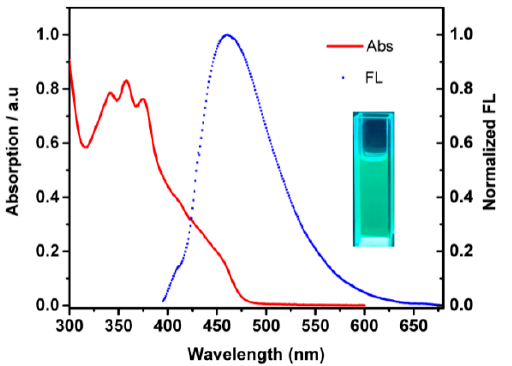
Figure 2. UV-vis absorption (red line) and emission (blue dots) spectra of PyDN in toluene. Insets is photograph achieved under black back light with excitation at 365 nm in toluene.